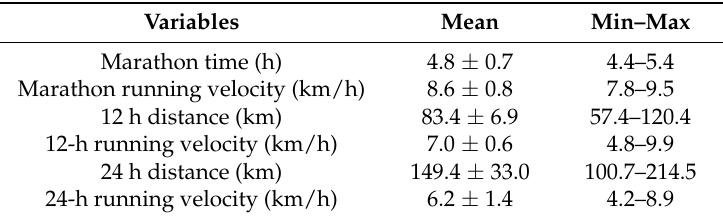
Table 2. Ultra-marathon race performance measures.